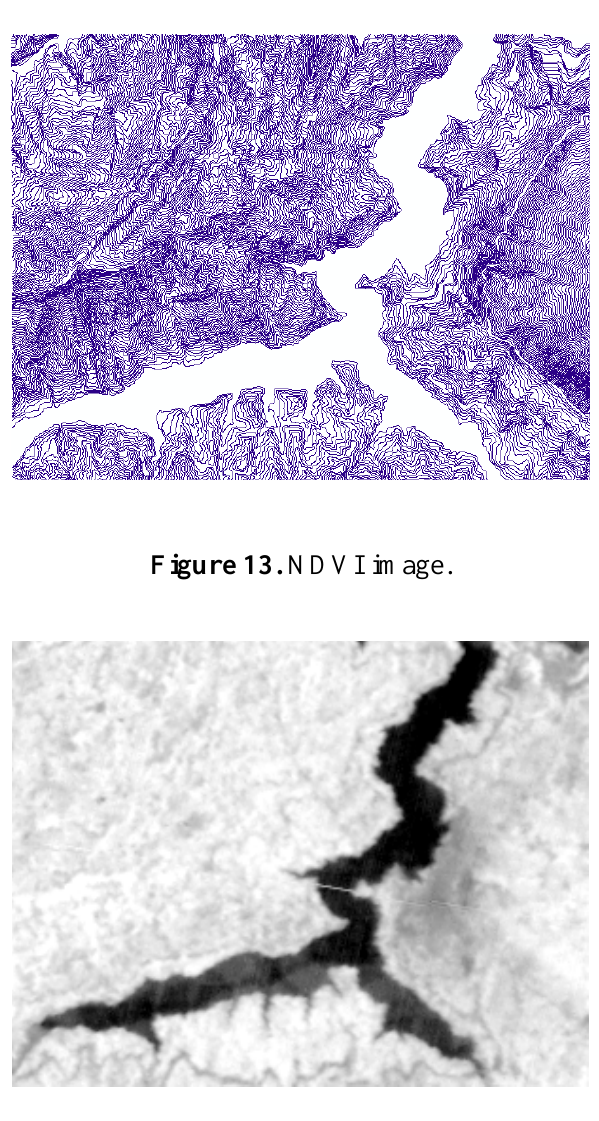
Figure 12. Contour.